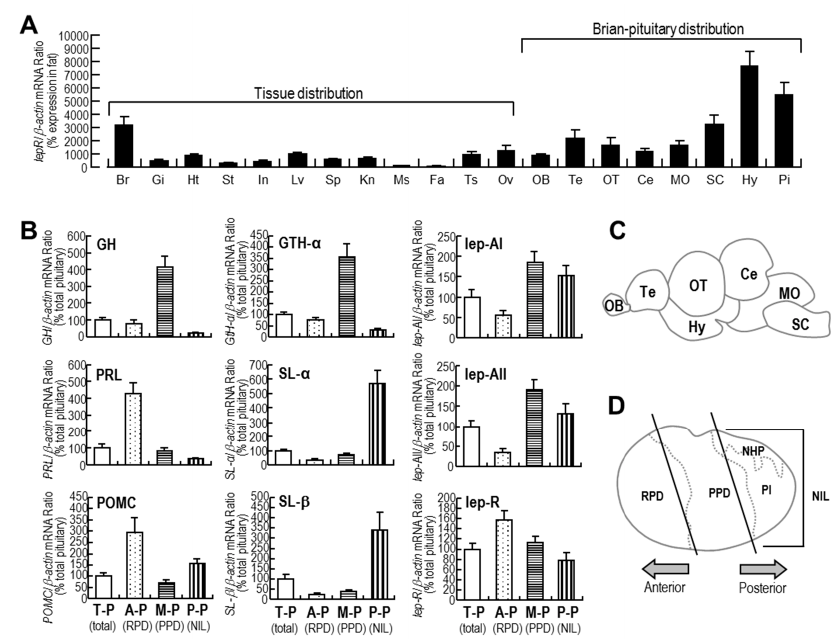
Figure 2. ( A ) Expression profiles of goldfish lepR in various tissues and brain regions, including brain (Br), gill (Gi), heart (Ht), intestine (In), liver (Lv), spleen (Sp), kidney (Kn), muscle (Ms), Fat (Fa), testis (Ts), ovary (Ov), the olfactory bulb (OB), telencephalon (Te), optic tectum (OT), cerebellum (Ce), medulla oblongata (MO), spinal cord (SC), hypothalamus (Hy), and pituitary (Pi), as assessed by real-time quantitative (qPCR); ( B ) Expression pattern of major hormones, including GH , PRL , POMC , GTH- α , SL- α , SL- β , leptin -AI, leptin -AII and lepR, in different regions of pituitary assessed by qPCR. T-P indicates total pituitary; A-P indicates anterior pituitary, corresponding to rostral pars distalis (RPD) in mammalian pituitary; M-P indicates medium pituitary, corresponding to proximal pars distalis (PPD) in mammalian pituitary; P-P indicates posterior pituitary corresponding to neurointermediate lobe (NIL), consisting of neurohypophysis (NHP) and pars intermedia (PI) in mammalian pituitary; ( C ) diagram showing the goldfish brain regions; ( D ) diagram showing different parts of the goldfish pituitary. In these studies, data are expressed as the mean ± SE ( n = 3 for testis and ovary, and n = 6 for other tissue and pituitary samples).